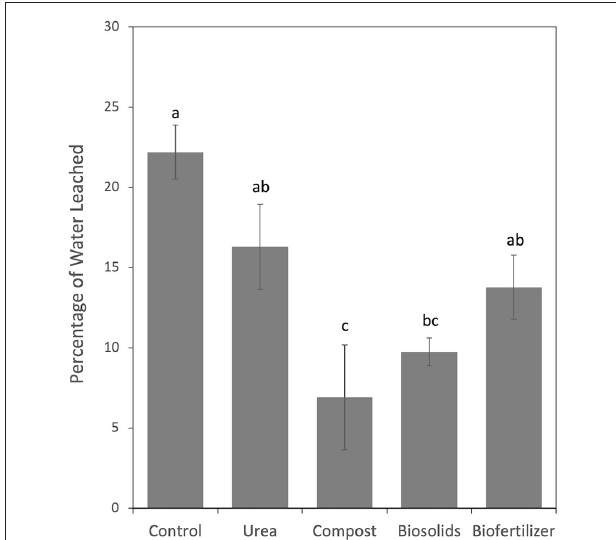
FIGURE 5 | Cumulative water lost via leaching as a percentage of cumulative water applied. Bars represent treatment means. Error bars indicate ± standard error. Letters indicate significant treatment differences as determined by an ANOVA and post hoc Tukey means comparison test with significance determined as p <